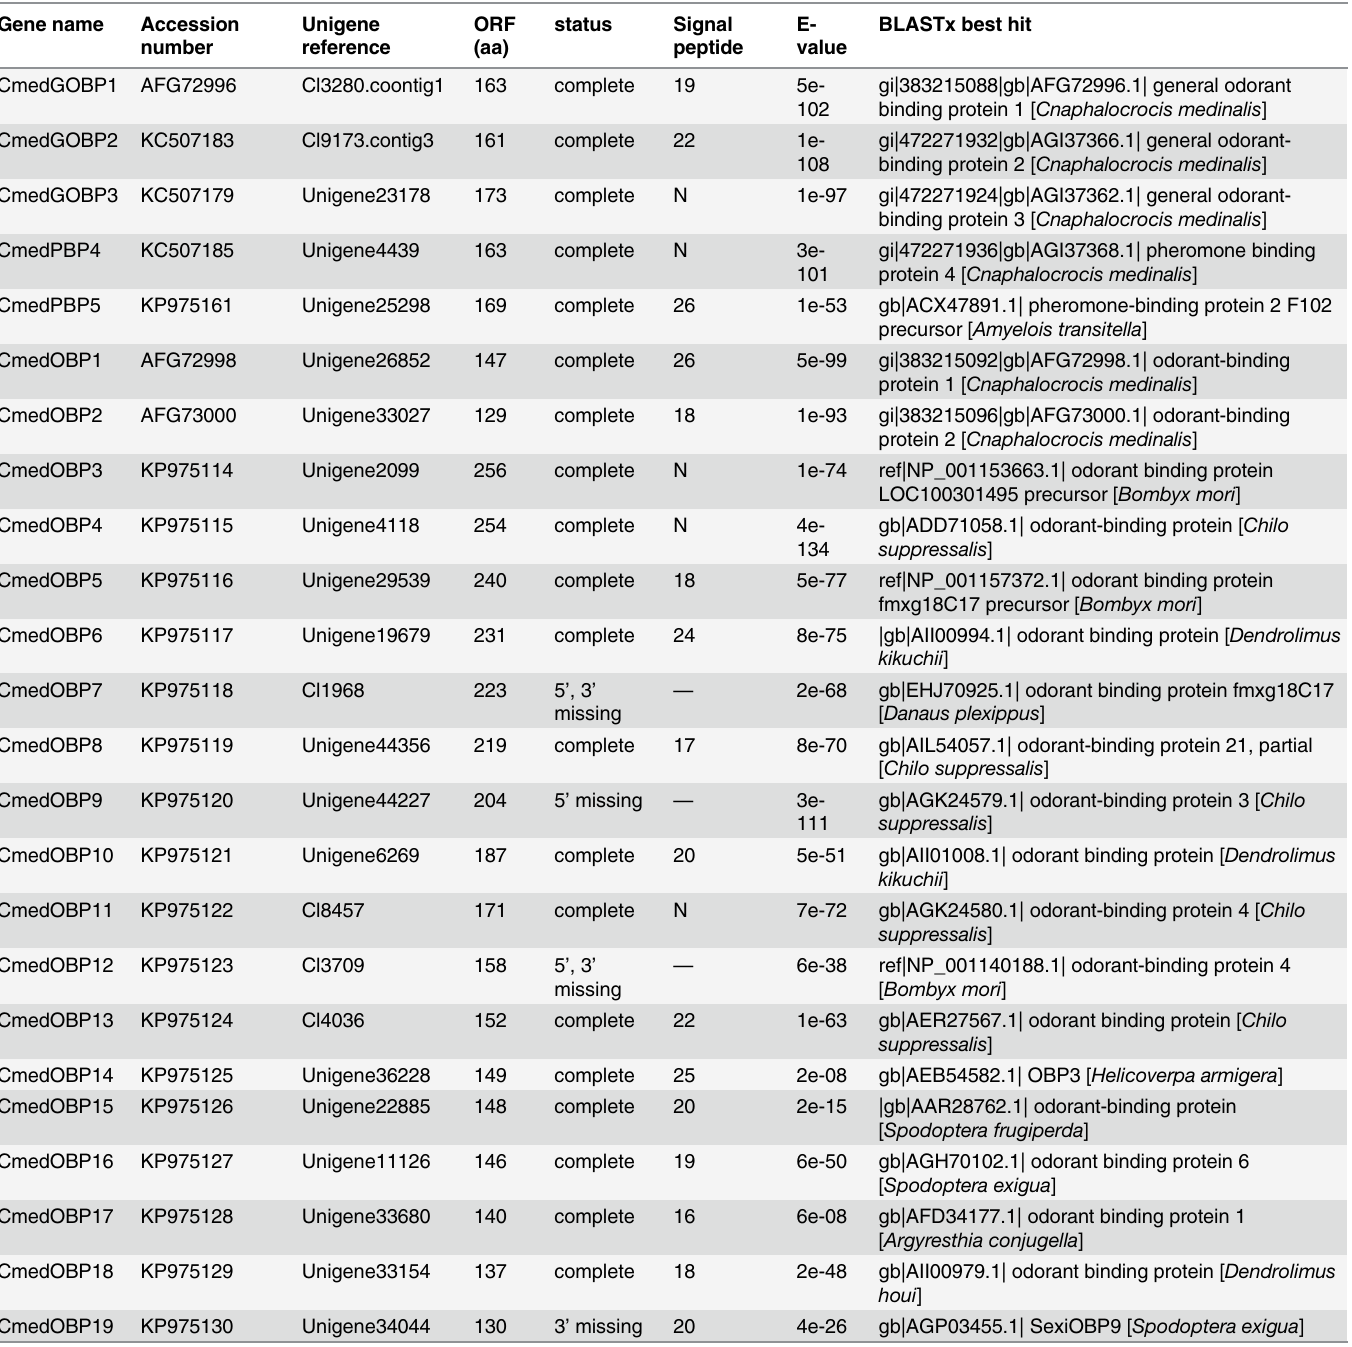
Table 5. Unigenes of candidates for odorant binding